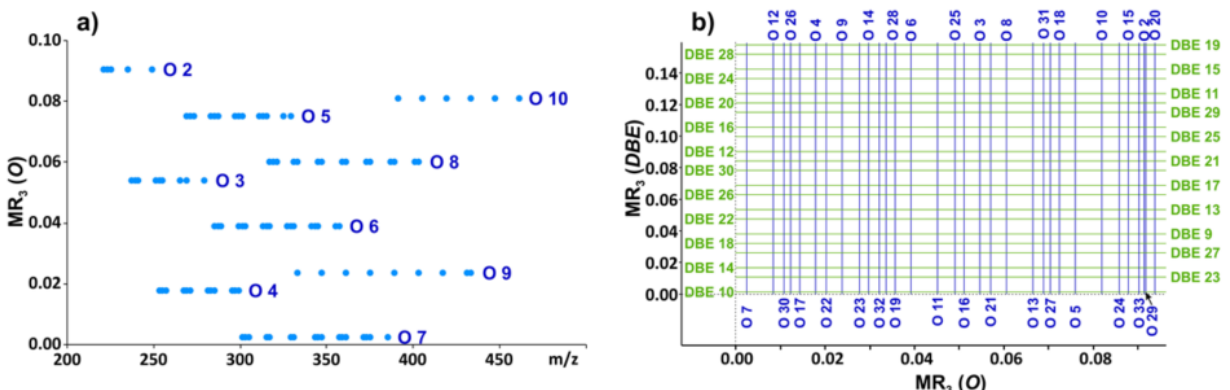
Figure 2. ( a ) MR 3 versu s m/z plot calculated from the theoretical m/z values of about one hundred flavonoids (applied for Figure 1d). ( O in parenthesis indicates that the number of oxygen atoms were revealed as the characteristic difference.) ( b ) MR 3 ( DBE )—MR 3 ( O ) mesh used as a mass spectral